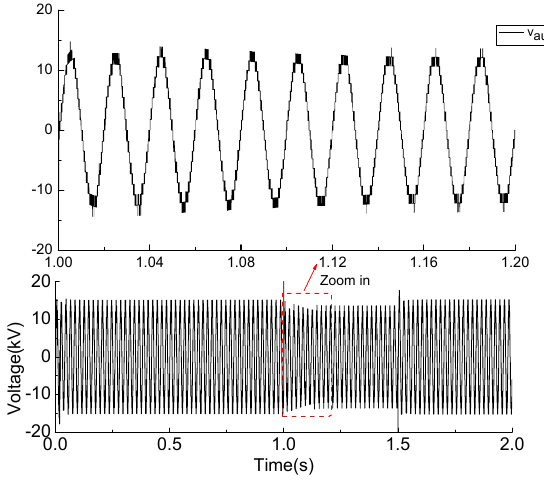
reference frames: ( a ) positive sequence voltages; ( b ) negative sequence voltages.